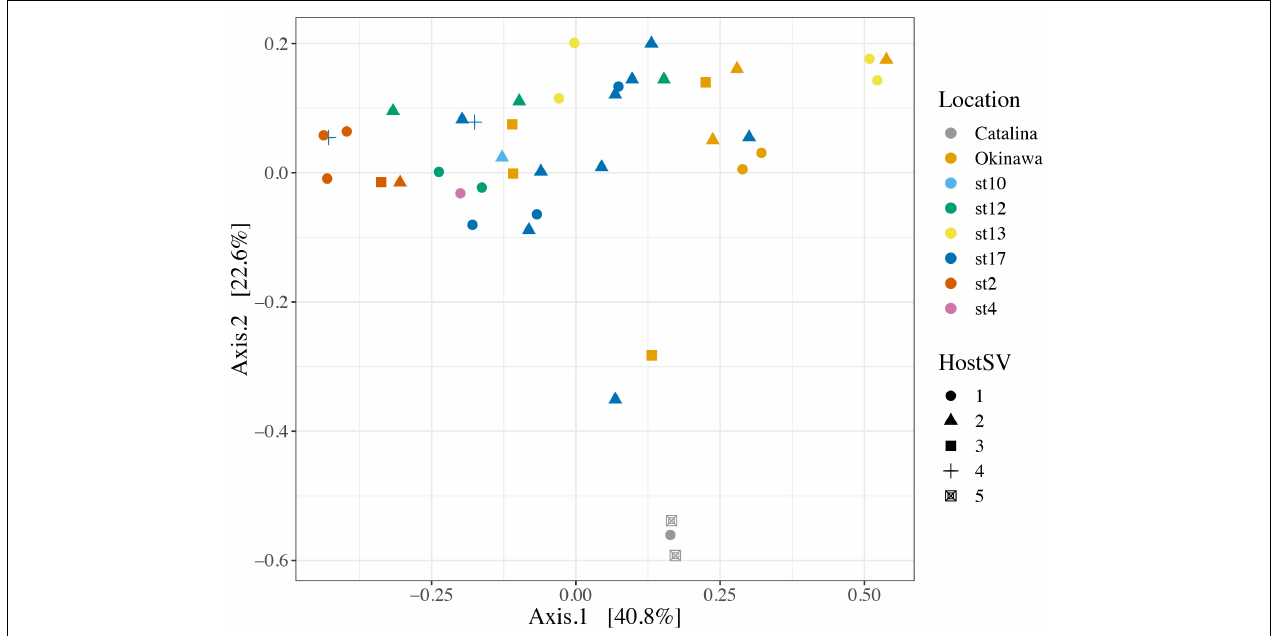
FIGURE 4 | Principal Coordinates Analysis of Bray-Curtis distances between symbiont communities within individual acantharian hosts. Point shape corresponds to host SV and color corresponds to the collection location of the host acantharians ( n = 42, 1–14 per site). The symbiont communities associated with acantharians collected near Catalina Island and from ECS station 2 form clusters, while communities from the other locations do not cluster separately. A PERMANOVA by location (excluding st. 4 and st. 10 due to insufficient sample size) performed with the adonis function in the R package vegan on the Bray-Curtis distances between symbiont communities confirmed that collection location had a significant effect on symbiont community ( p = 0.001, R 2 = 0.47 after 999 permutations). Host SV also had a significant effect ( p = 0.009, R 2 = 0.19), but only SV 5 was significantly different when pairwise PERMANOVA comparisons were performed in Qiime2. Bray-Curtis distance and PCoA ordination were performed with R package phyloseq and the plot was rendered with R package